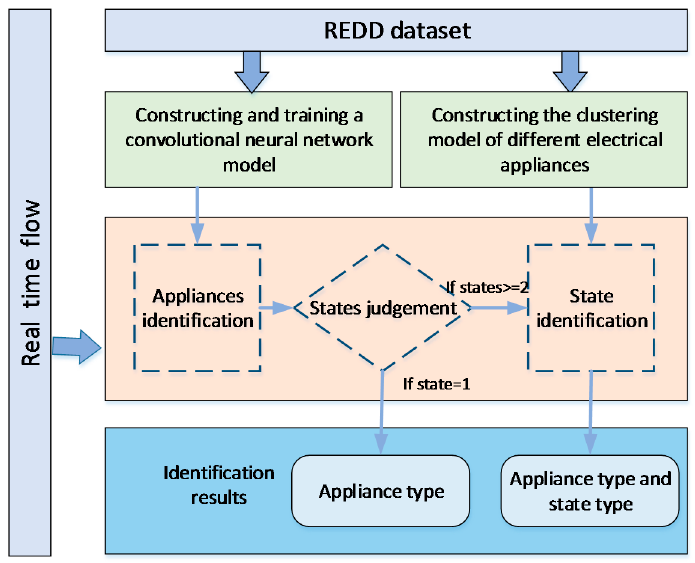
Figure 6. Flow chart of the method.